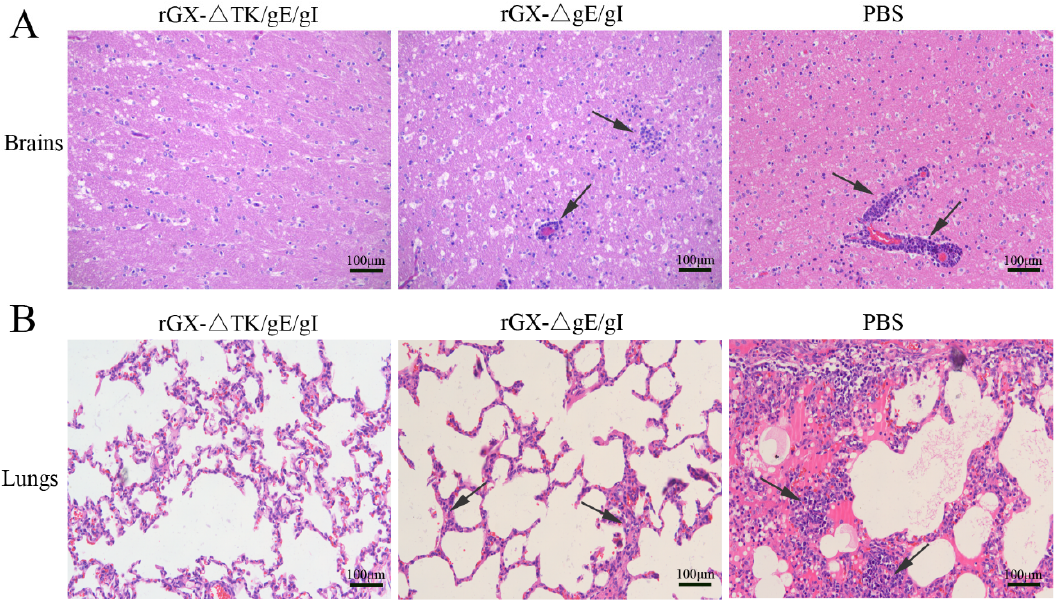
Figure 7. The e ff ect of the gE / gI- and gE / gI / TK-gene-deleted PRV on histopathology in the brain and lung tissues of pigs. ( A , B ) HE staining was carried out to measure pathological lesions of brain and Figure 7. The effect of the gE/gI- and gE/gI/TK-gene-deleted PRV on histopathology in the brain and lung tissues in pigs. Scale bar, 50 or 100 µ m. Arrows indicate the cell infiltrates. HE, hematoxylin and lung tissues of pigs. ( A,B ) HE staining was carried out to measure pathological lesions of brain and eosin lung tissues in pigs. Scale bar, 50 or 100 μ m. Arrows indicate the cell infiltrates. HE, hematoxylin and eosin staining.